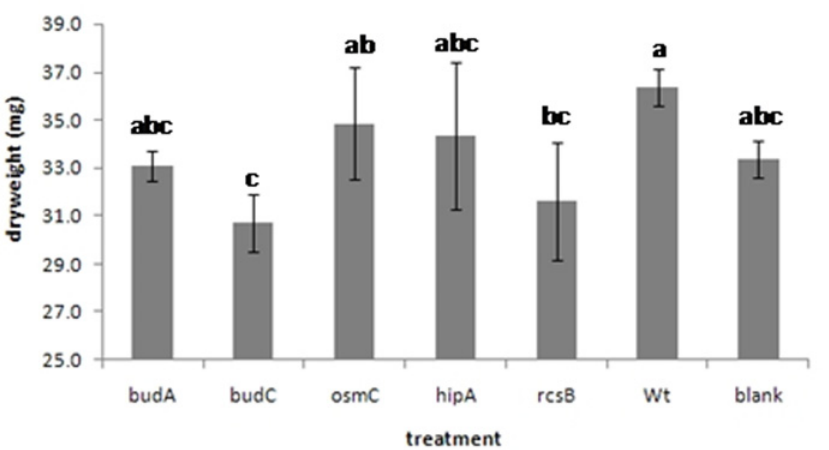
Figure 5. The effects of various mutations on the growth of wheat plants after inoculation with wild- type strain Enterobacter sp. 638 and its derivatives. Derivatives containing knock-out mutations for the following genes were examined for their effects on wheat growth: budA and budB , required for acetoin and 2,3-butanediol synthesis, respectively; hipA , the toxin of the hipAB toxin-antitoxin system; the rcsB regulator; and osmC , which is important in biofilm formation and under positive control of the rcsAB regulatory network in E. coli . The error bars show the standard deviation (SD). Different letters on top of each column represent the significance at the 0.05